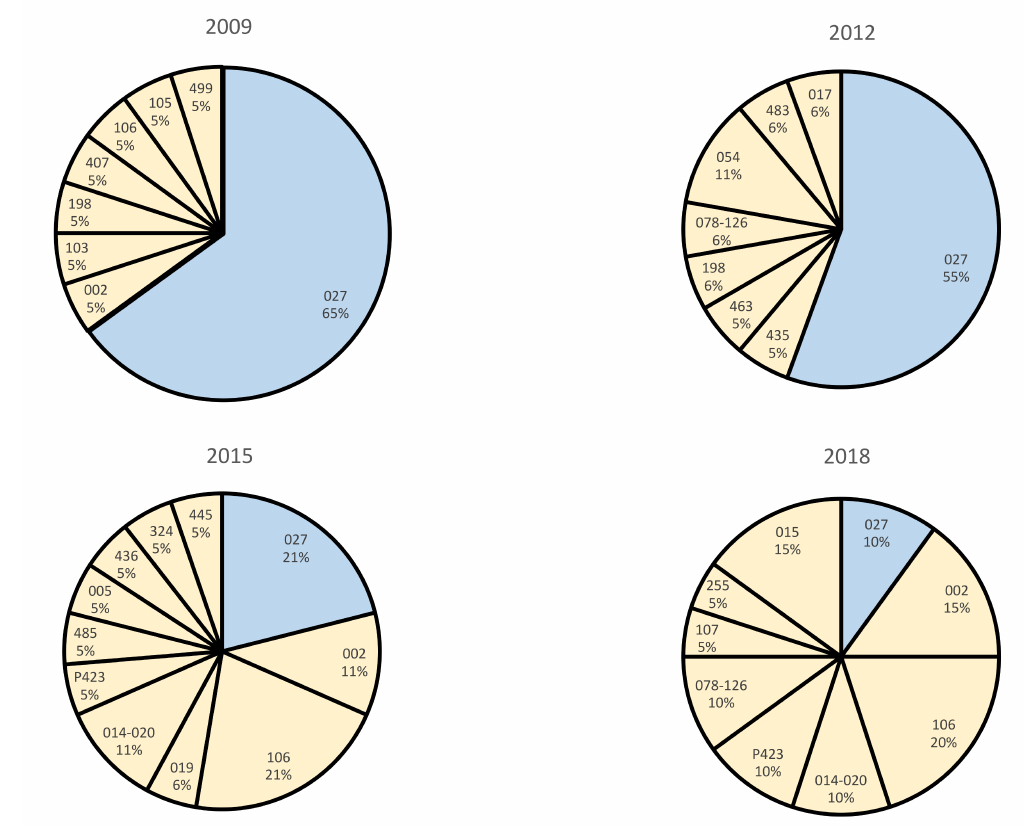
Figure 2 . Distribution of polymerase chain reaction ribotypes of Clostridioides difficile isolates recovered from stool specimens testing positive for C. difficile during 4 representative years in a 10-year period. There were a total of 203 isolates (20 to 23 per year) subjected to